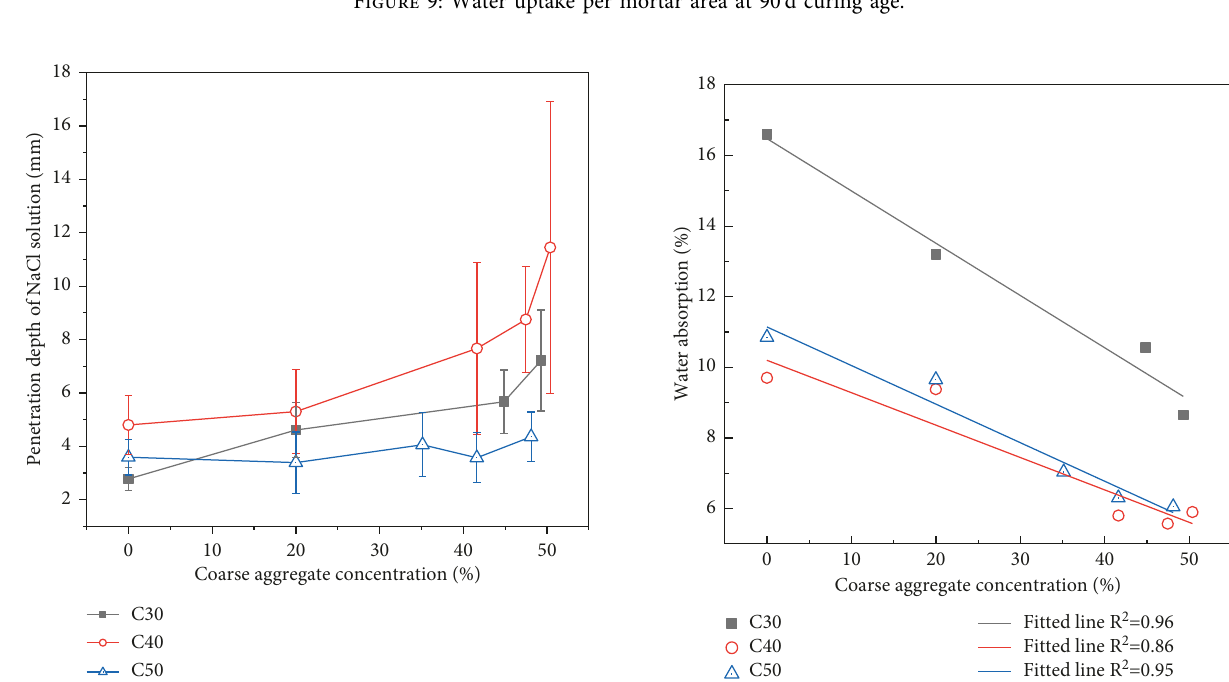
Figure 10: Relationship between penetration depth of NaCl so- lution and coarse aggregate concentration.